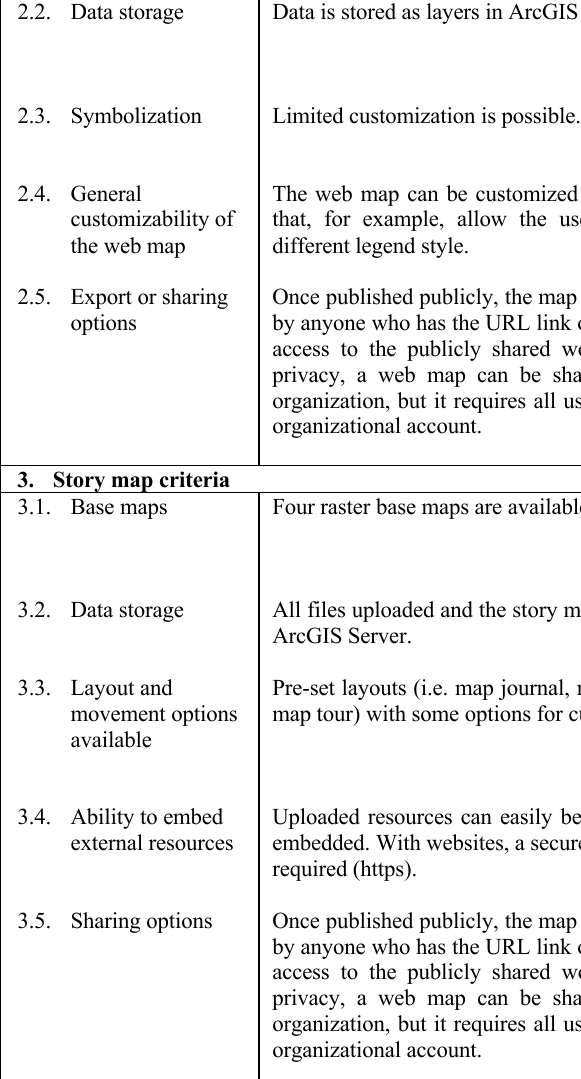
Table 2. Evaluation of Esri ArcGIS Online and